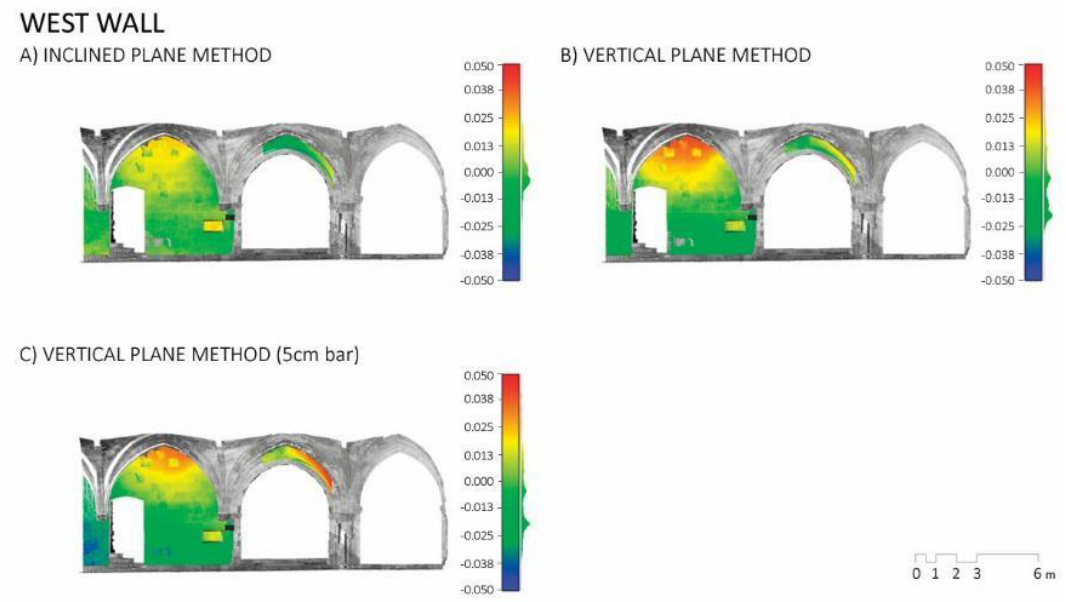
Figure 8. Distance maps of inner west wall (units in meters).